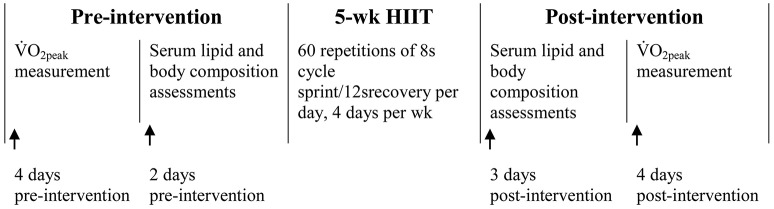
The timeline of pre-and post-intervention measurements, as well as the 5-wk intervention of high-intensity interval training (HIIT).